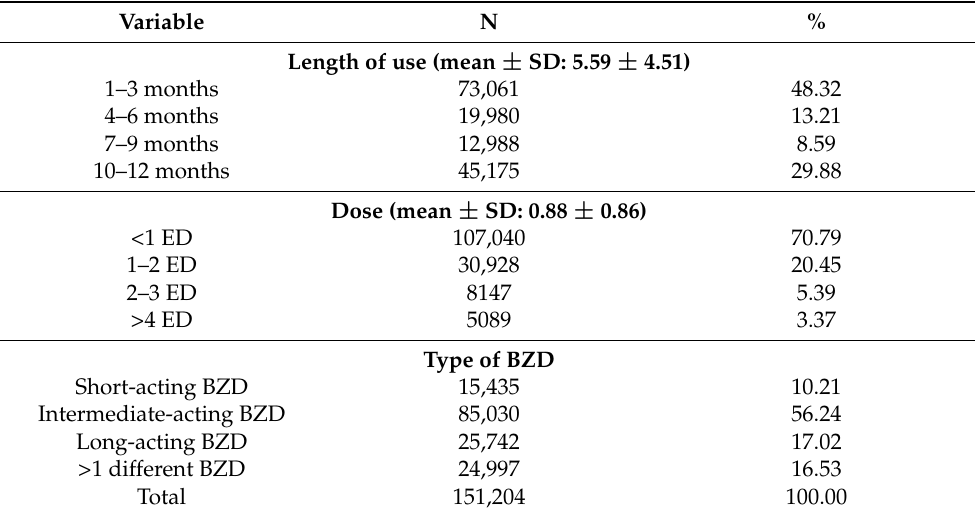
Table 3. Dose, length of use, and type of benzodiazepines